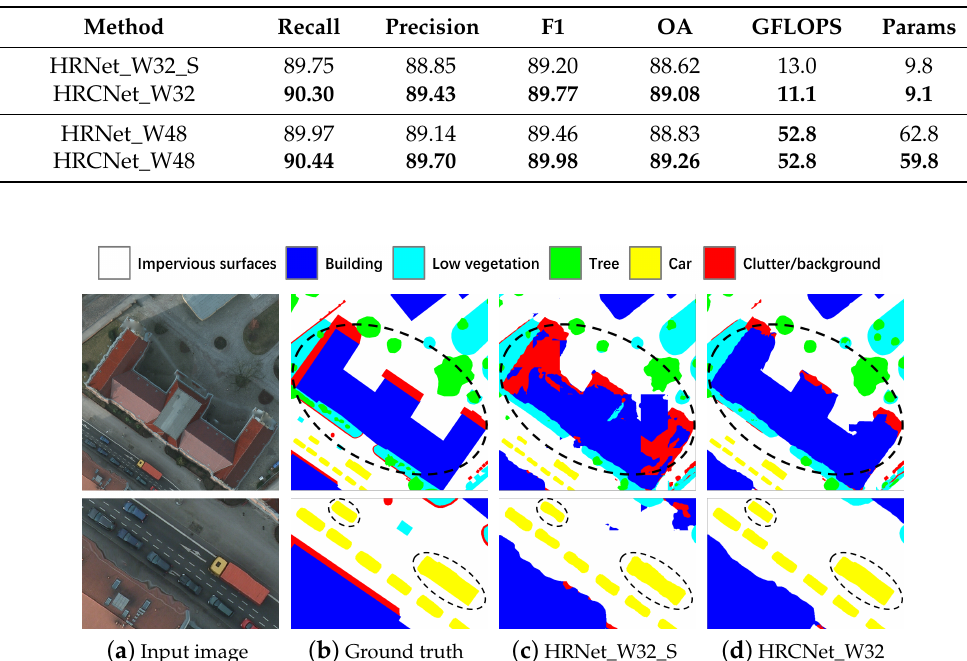
Table 12. The ablation experiments evaluated by F1 (%), OA (%), GFLOPS (G) and Params (M) about the multi-level loss functions.